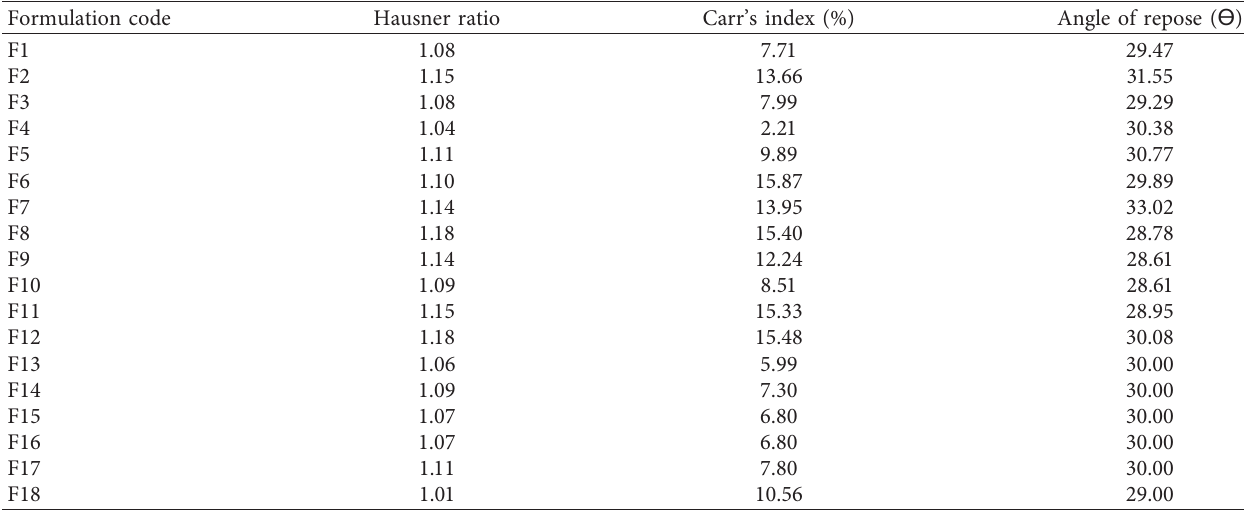
Figure 2: FTIR spectra of pure paracetamol (active), okra pectin (PC5), and the physical mixture of paracetamol and okra pectin (PC5+active). Table 3: Flow properties of formulated granules.